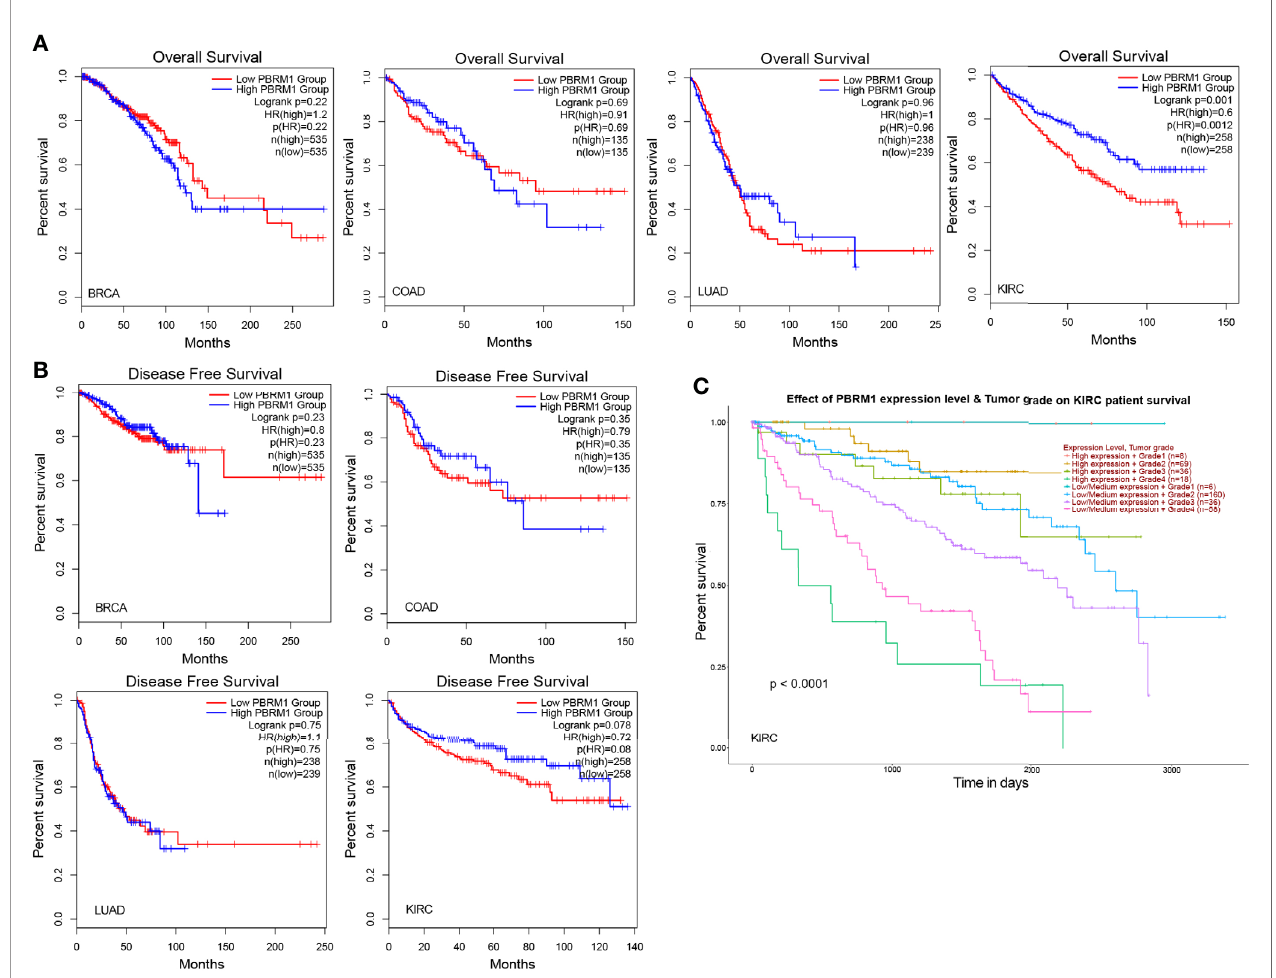
FIGURE 3 | The mutation of PBRM1 affects the survival rates of patients. Overall survival (A) and disease-free survival (B) of PBRM1 high and PBRM1 low patients in different tumors. GEPIA2 tool was used to analyze the TCGA dataset. BRCA, breast invasive carcinoma; COAD, colon adenocarcinoma; LUAD, lung adenocarcinoma; KIRC, kidney renal clear cell carcinoma (ccRCC). (C) Overall survival of KIRC (ccRCC) patients based on the PBRM1 expression level and tumor grade. Kaplan-Meier curves with positive results are